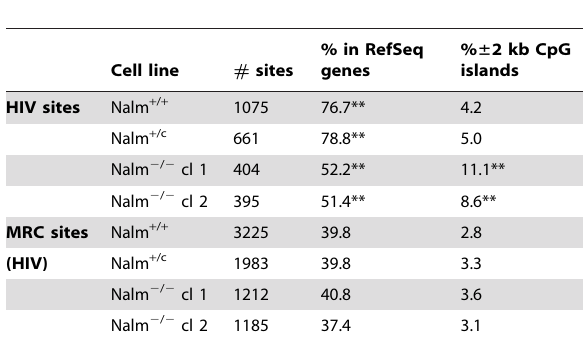
Table 1. Integration frequency near mapped genomic features in the human